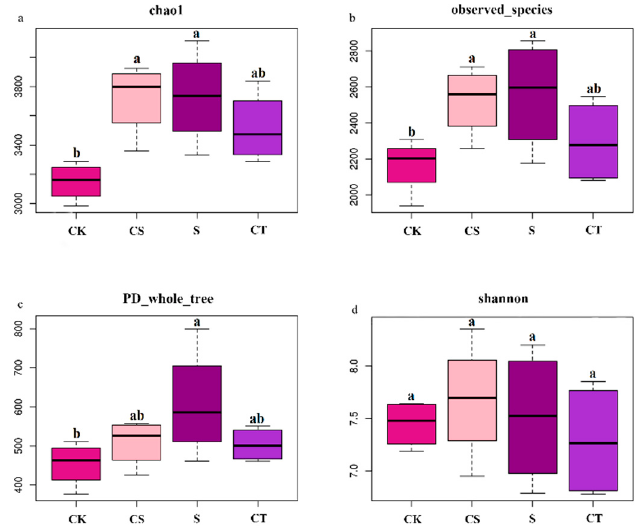
Figure 2. Comparison of the estimated OTU α -diversity indexes (( a ): chao1, ( b ): observed_species, ( c ): PD_whole_tree, ( d ): shannon) of the phoD microbial community in different fertilizer treatments. Different lowercase letters indicate a significant difference between treatments ( p < 0.05).